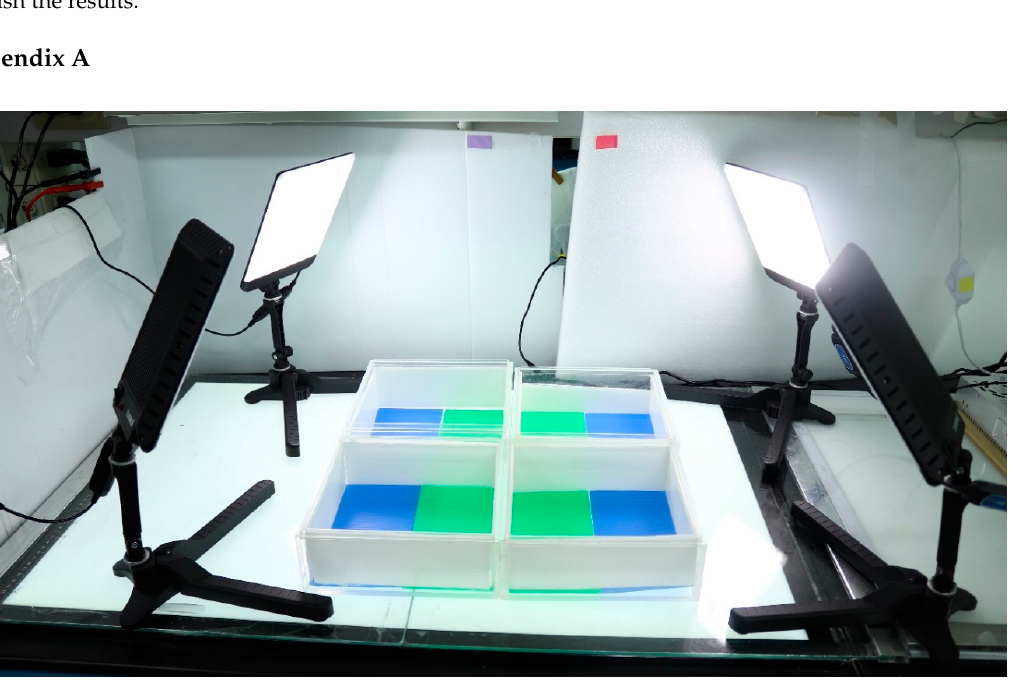
Figure A1. Instrument setting used to perform the color preference test in zebrafish. Table A1. Illumination condition of the top and bottom light sources.